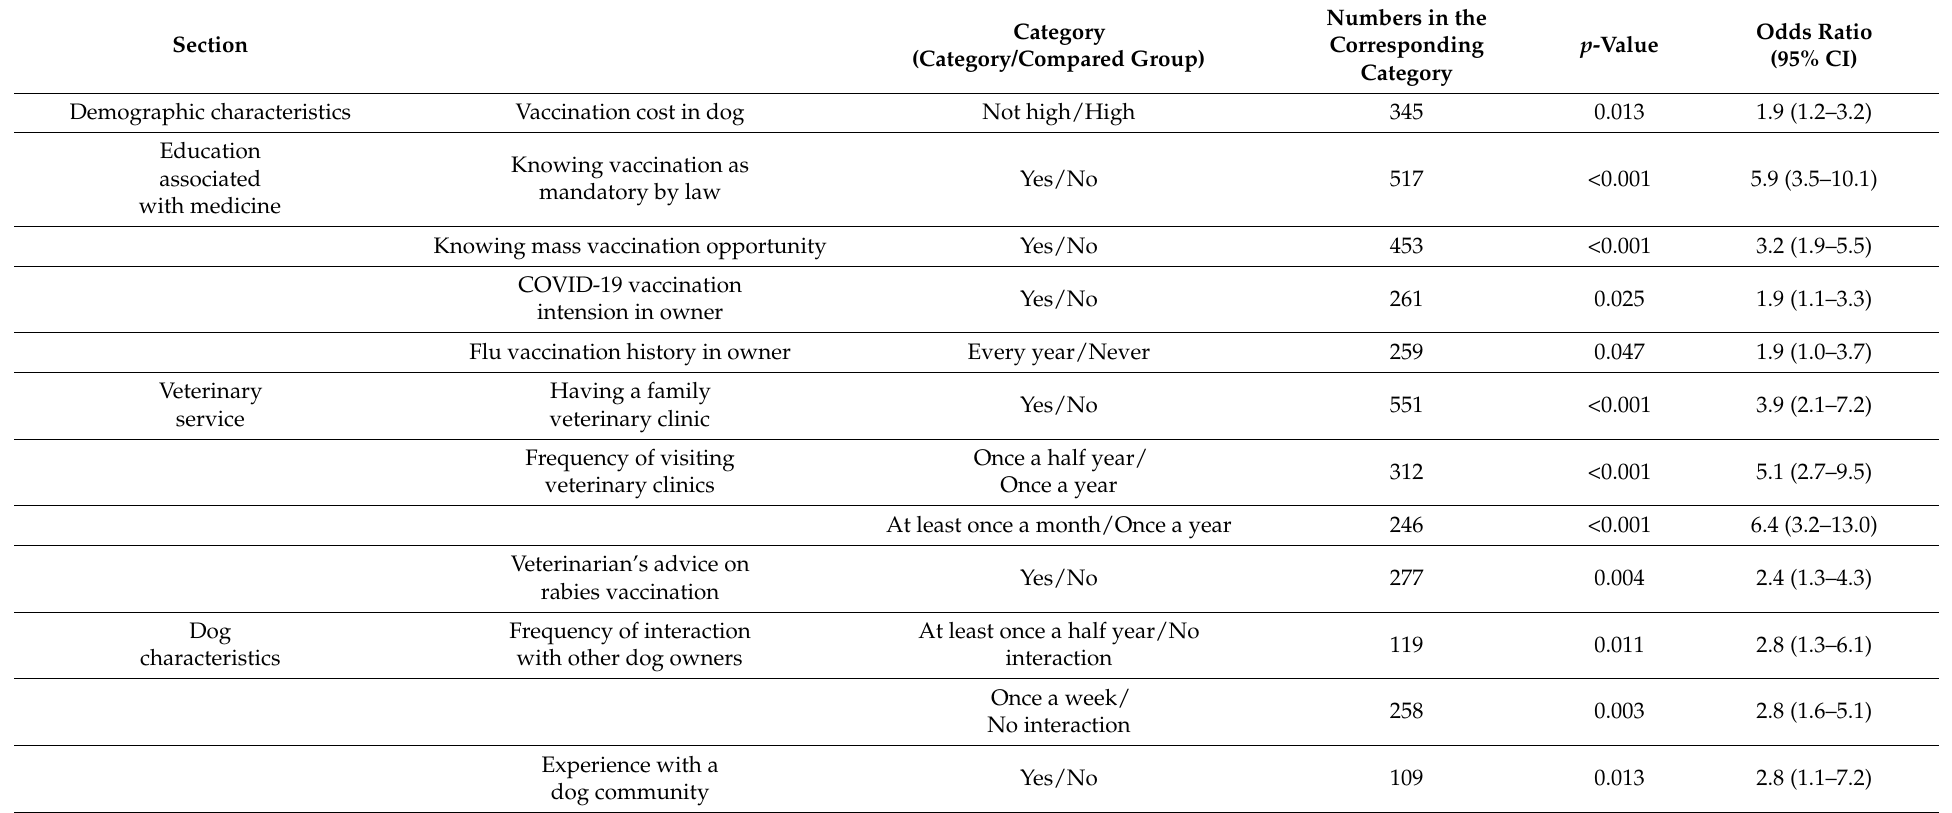
Table 4. Univariate associations between dog registration and owner